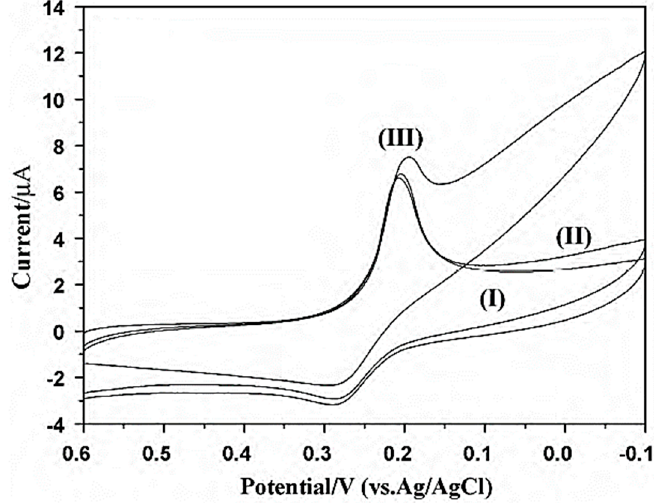
Figure 6. Cyclic voltammograms of green-synthesized graphene oxide nanomaterial [99]. (I) = 0 mM; (II) = 0.1 mM; and (III) = 0.5 mM of H 2 O 2 at scan rate of 50 mVs − 1 . Reproduced with permission from Elsevier.